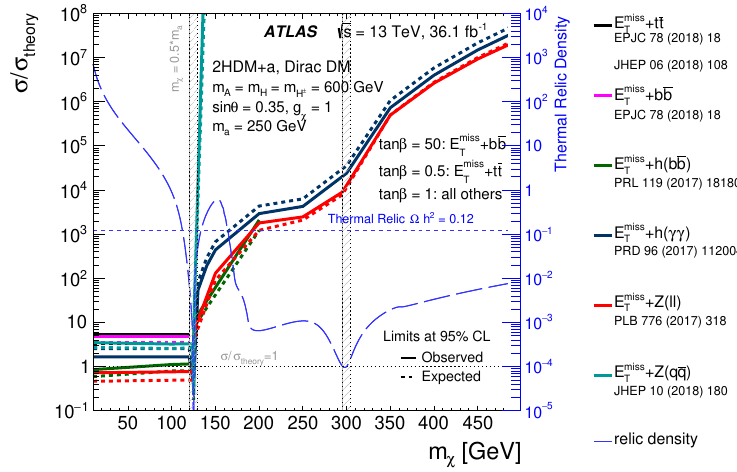
Figure 21. Observed exclusion limits for the 2HDM+ a model as a function of m (cid:31) , following the parameter choices of scenario 4. The limits are calculated at 95% CL and are expressed in terms of the ratio of the excluded cross-section to the nominal cross-section of the model. The relic density for each m (cid:31) assumption is superimposed in the plot (long-dashed line) and described by the right vertical axis. For DM mass values where the relic density line is below (cid:10) h 2 = 0 : 12, the model depletes the relic density to below the thermal value. The two valleys at m (cid:31) = 125 GeV